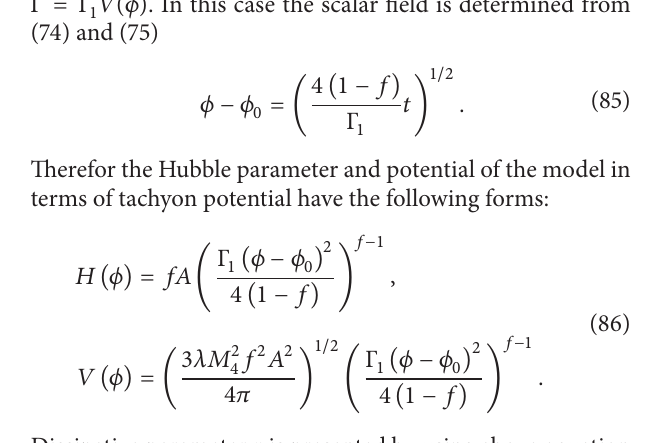
Figure 2: In this graph we plot the scalar-tensor ratio 𝑅 in terms of the number of e-folds 𝑁 . We can find best range of tensor-scalar ratio, where 60 < 𝑁 < 80 .